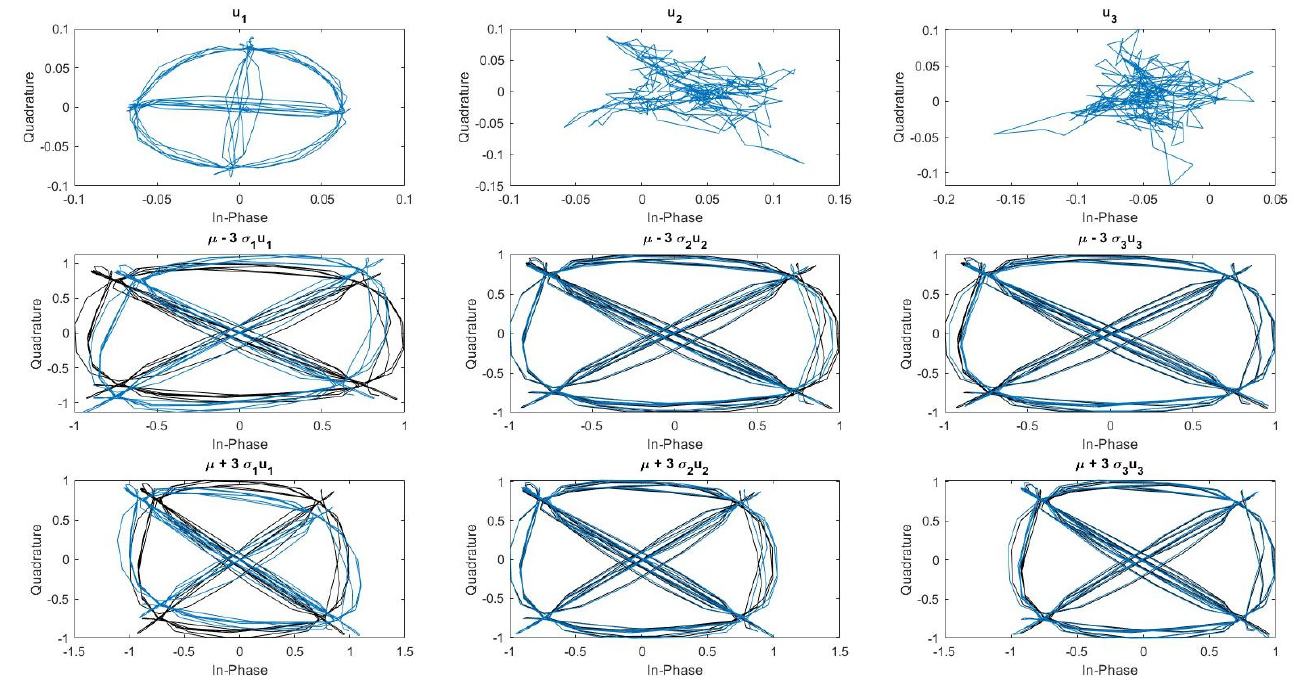
Figure 6. Visualisation of learned